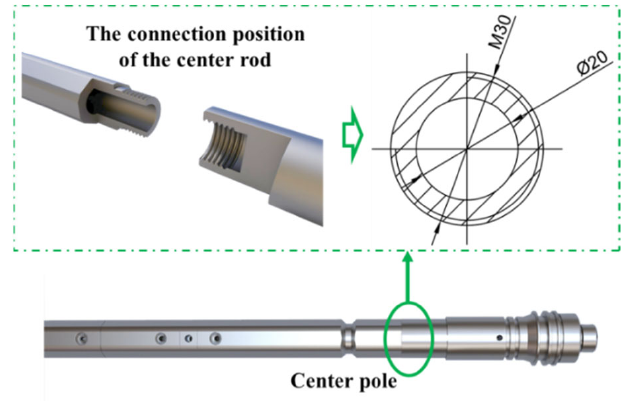
Figure 7. Sectional size of the connecting position of the center pole.